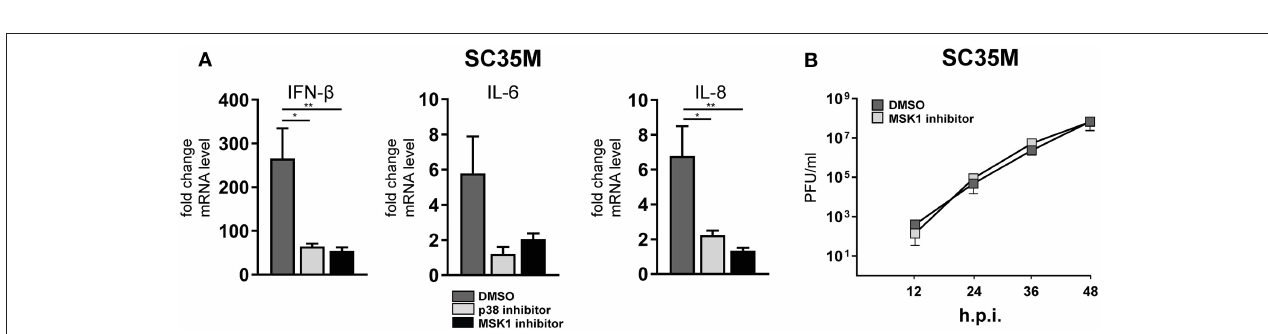
FIGURE 6 | Inhibition of p38 and MSK1 ablates TRIM28 S473 phosphorylation. A549 cells were pre-treated with inhibitors for (A) p38 (SB202190), (B) MEK (U0126), (C) MSK1 (SB747651), and (D) MK2 (PF-3644022) at 0.1 µ M, 0.5 µ M, 1 µ M, 5 µ M and 10 µ M before infection with SC35M at an MOI of 20 for 10h and further incubation with the inhibitors. Lysates were examined with a phospho-specific antibody for TRIM28 S473 phosphorylation. Infection was verified by detection of the viral PB1 protein. Tubulin and total TRIM28 served as loading controls. MEK and MK2 inhibition was controlled by detection of ERK T202/Y204, and HSP27 S82 phosphorylation, respectively. (E) A549 cells were pre-treated with p38 (SB202190), MEK (U0126), MSK1 (SB747651) and MK2 (PF-3644022) inhibitors at 1 µ M for 30min. Pre-treated cells were transfected with 500 ng viral or cellular in the presence of the corresponding inhibitors. Lysates were harvested 4h p.t. and TRIM28 S473 phosphorylation was analyzed by western blot.